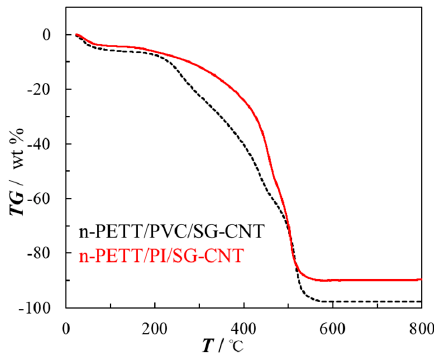
Figure 5. Comparison of thermogravimetric analyses of nano-PETT/PI/SG-CNT (red line) and nano-PETT/PVC/SG-CNT (black line) hybrid films. Mass ratio: nano-PETT/polymer/SG-CNT = 9/3/8.